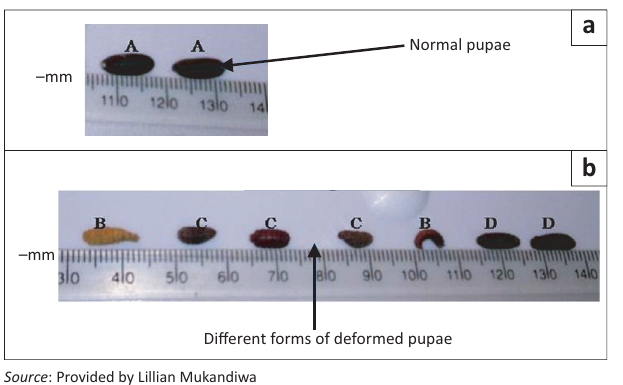
Different forms of deformed